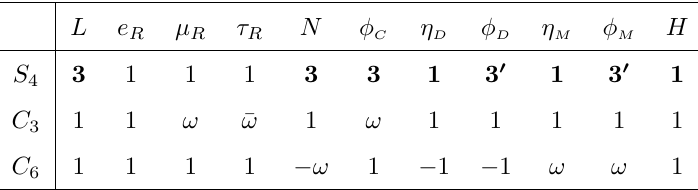
Table 2 . The (cid:13)avour structure of the model. The complex cube roots of unity, e i 2 (cid:25) 3 and e (cid:0) i 2 (cid:25) 3 , are represented by ! and (cid:22) !